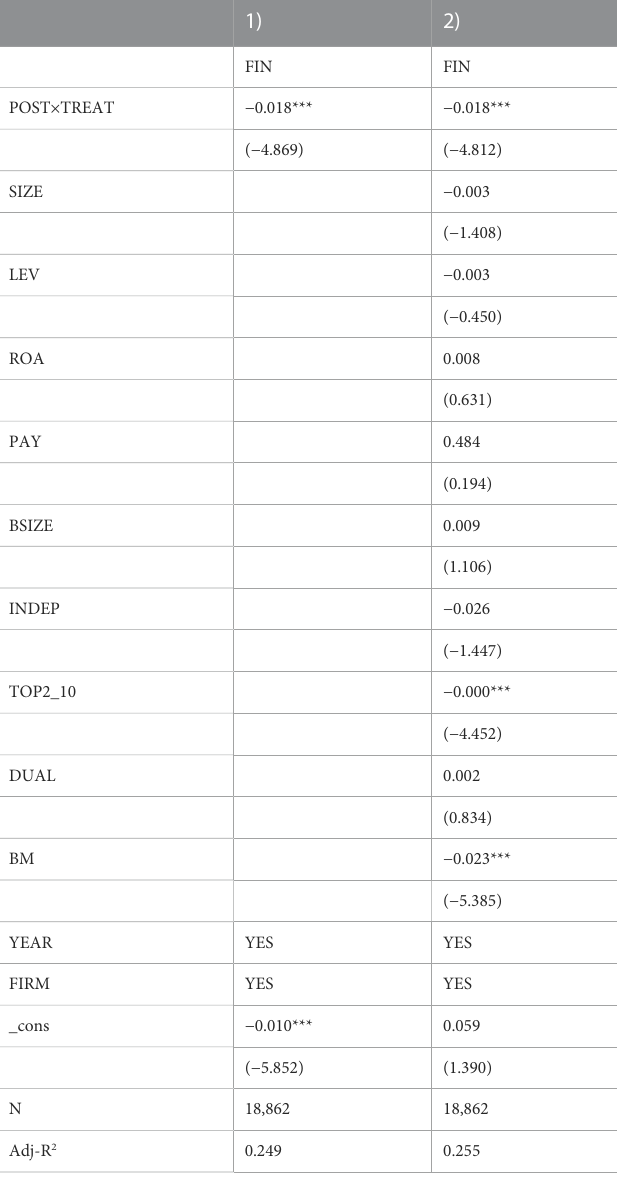
TABLE 8 Removing real estate industry samples. 1)